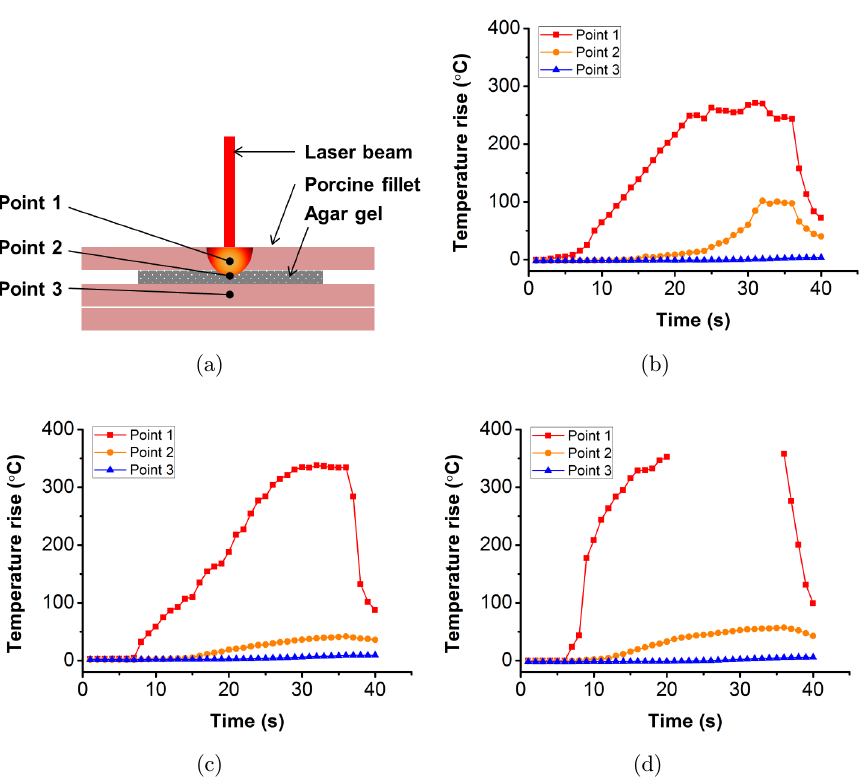
Fig. 6. Time course of temperature rise at di®erent depths in multi-layered porcine tissue-agar gel model for each condition over the course of a 40-s laser irradiation at 10 W. (a) Schematic of multi-layered porcine tissue-agar gel model and indications of the points for temperature measurements. (b) No gel, (c) colorless normal gel, and (d) black